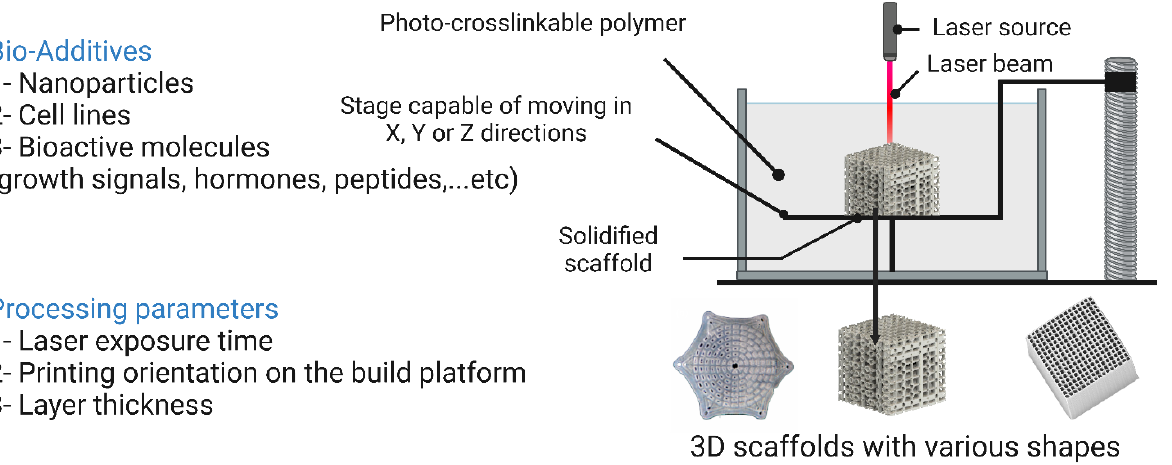
Figure 15. Stereolithography technique and its processing parameters and additives. The image was created using Biorender.